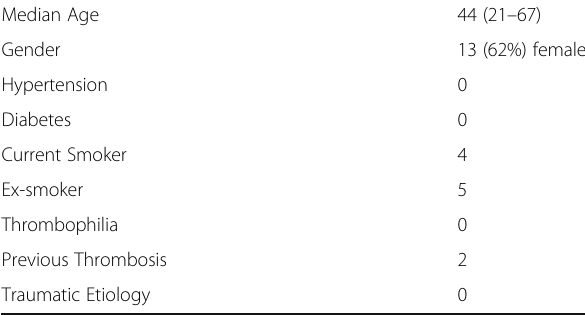
Table 1 Patients ’ risk factors for vascular disease and thrombus formation